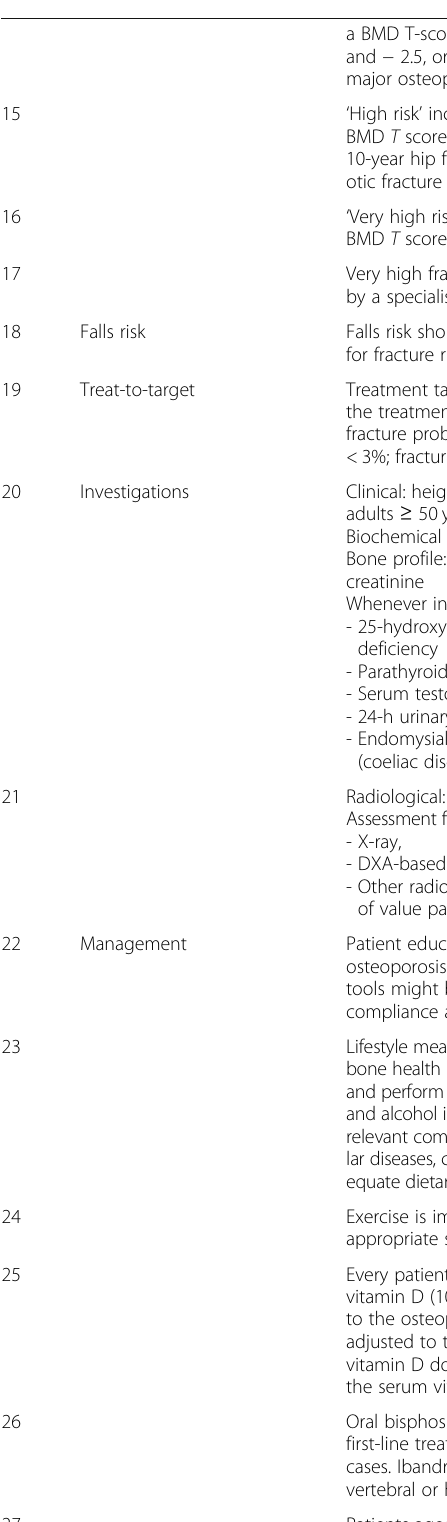
Table 2 Breakdown of statements of recommendations, its individual rank, and level of agreement (Continued)